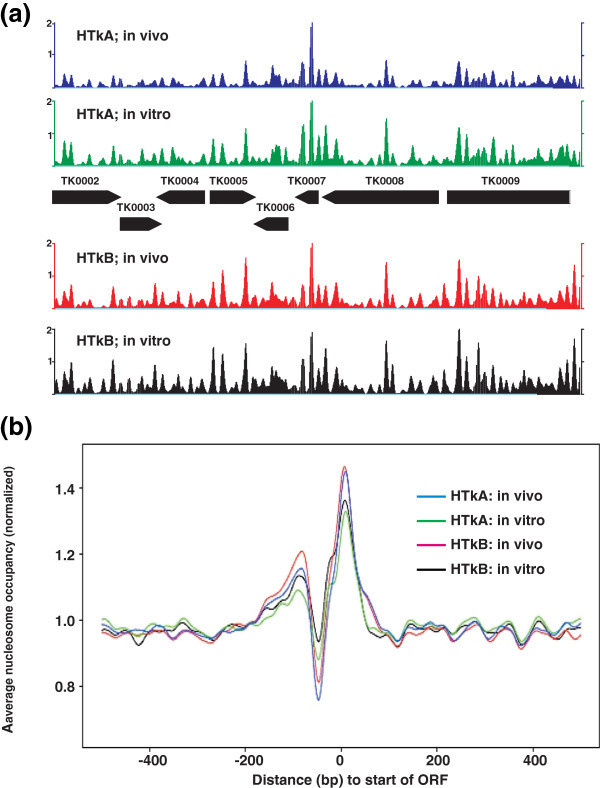
Archaeal nucleosome profiles in vivo are reproduced in vitro. (a) Profiles of the archaeal nucleosomes assembled in vivo and in vitro by HTkA and HTkB between nucleotide positions 5,000 and 10,000 on the T. kodakarensis genome. The organization of T. kodakarensis genes in this region is shown between upper and lower panels [34,39,42]. (b). The occurrence of nucleosome positions relative to the start codon of all open reading frames (ORFs), assembled by HTkA in vivo (blue line) and in vitro (green line), and by HTkB in vivo (red line) and in vitro (black line) normalized to the total number of nucleosomal reads from each sequencing experiment.